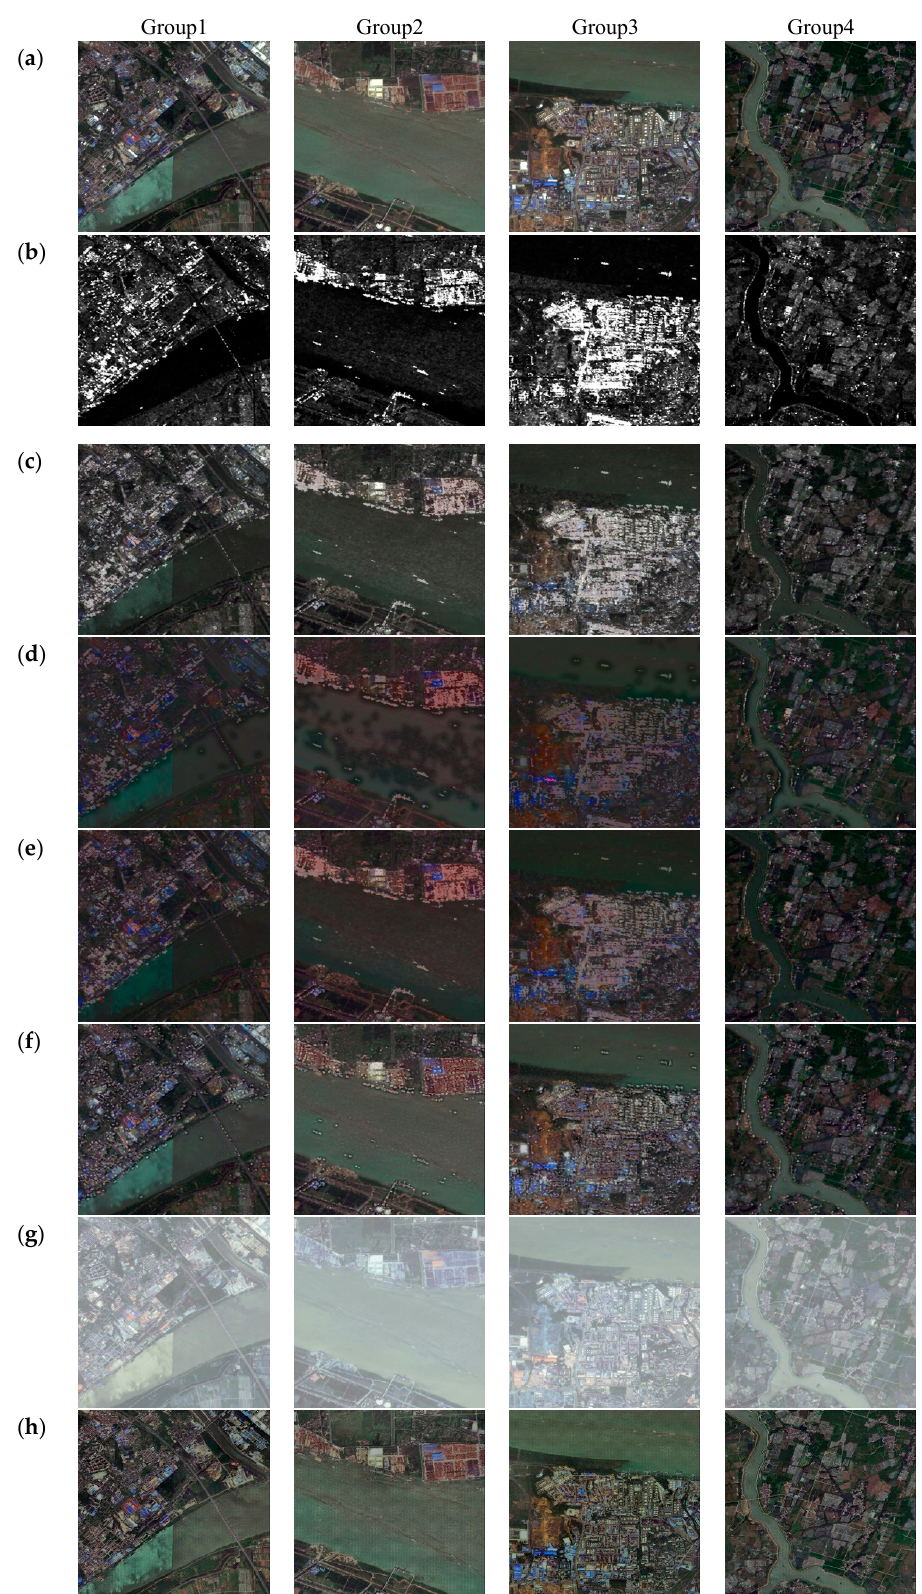
Figure 8. Effect comparison of the different fusion algorithms. (a) Optical image; (b) SAR image; (c) MWGF; (d) FFIF; (e) DWT; (f) NSCT; ( g ) Fusion ‐ GAN; (h) the proposed method.